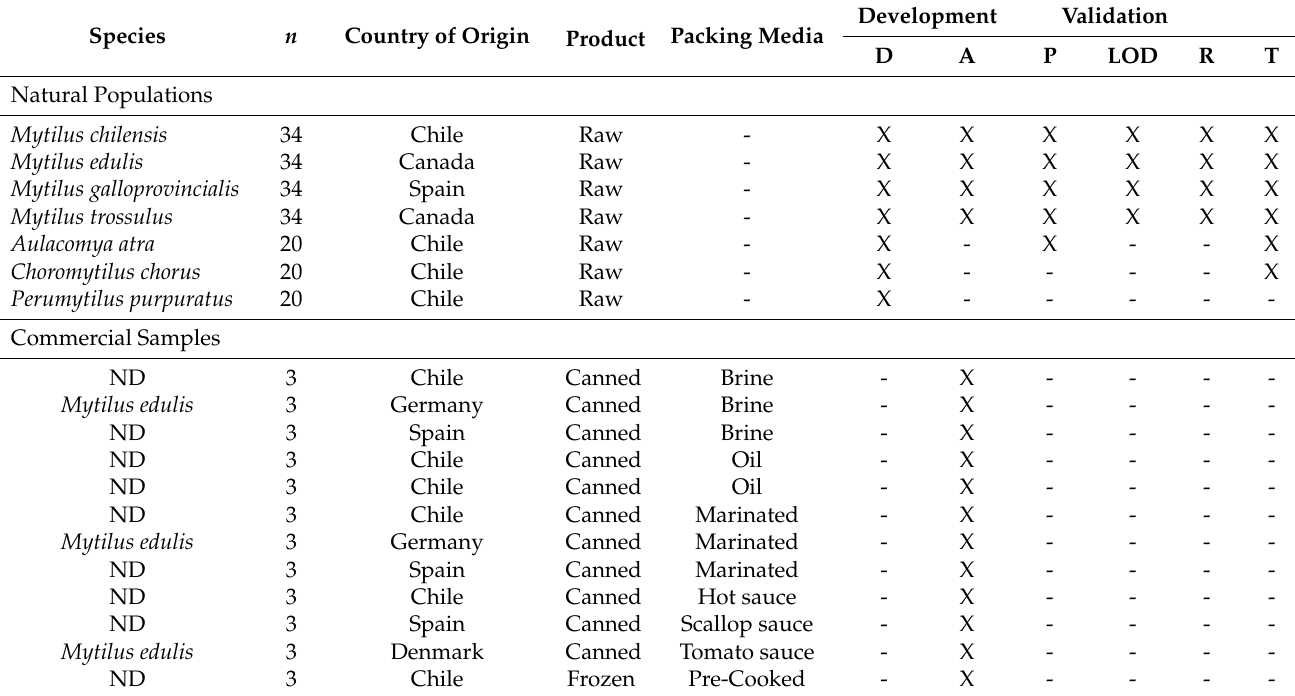
Table 1. Experimental design including type and number of samples analyzed in each step of the develop and validation